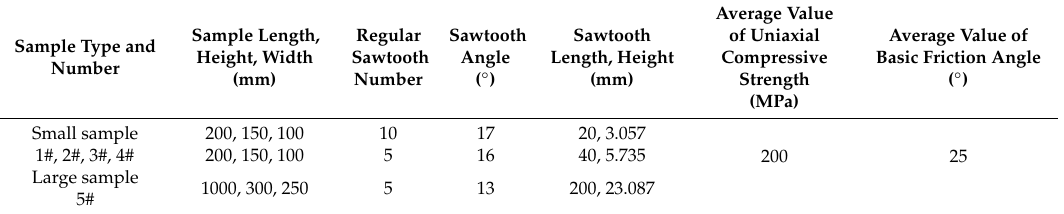
Figure 2. Schematic for granite discontinuity samples (unit: mm) ( a ) The positive and top views of small samples numbered from 1# to 3#; ( b ) The positive and top view of the small sample numbered 4#; ( c ) The positive and side view of the large sample numbered 5#. Table 2. Geometric and strength parameters of different discontinuity samples.